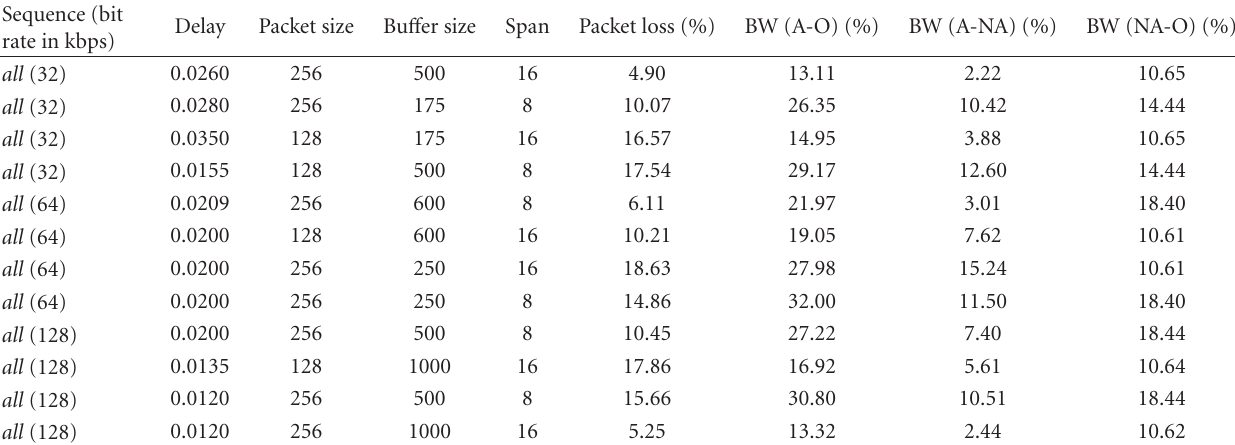
Table 3: Bandwidth utilization of QCIF sequences at di ff erent proxy parameters.